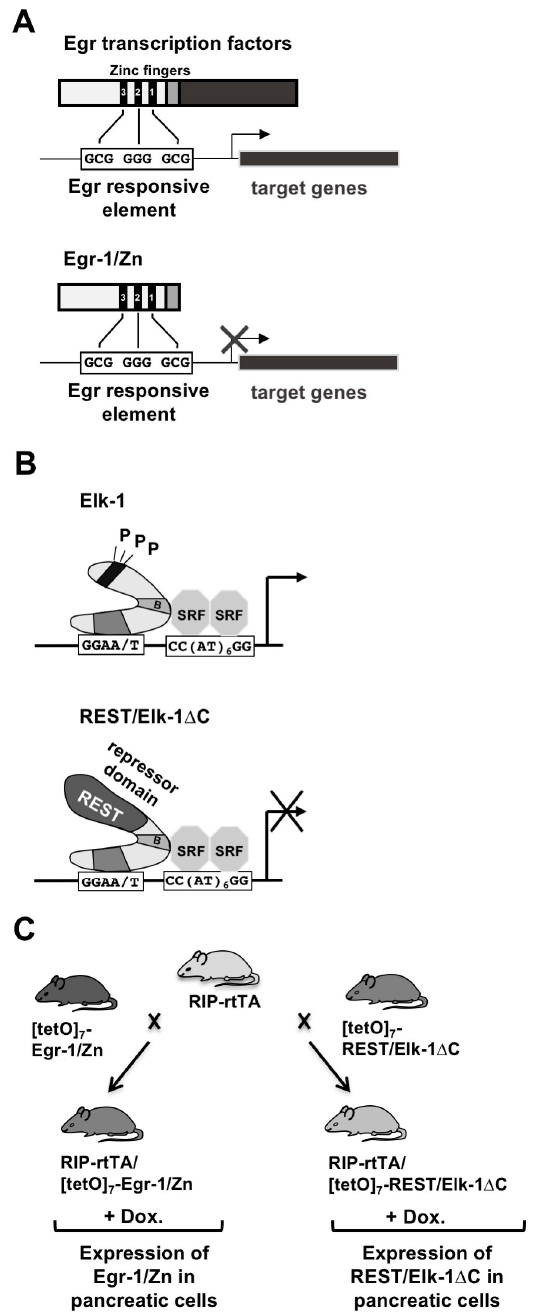
Figure 4. A transgenic strategy to overcome functional redundancy of protein families. ( A ) Egr-1/Zn functions as a dominant-negative for Egr proteins. Egr-1/Zn competes with Egr proteins for DNA binding. ( B ) REST/Elk-1 ∆ C functions as a dominant-negative for TCF proteins. REST/Elk-1 ∆ C competes with TCF proteins for DNA and SRF binding. In addition, the mutant induces chromatin compaction of SRE-regulated genes, due to the recruitment of histone deacetylases. ( C ) Crossing scheme to generate double transgenic mice expressing either Egr-1/Zn or REST/Elk-1 ∆ C in pancreatic β -cells. Reproduced with modifications from refs. [10,26] with permission from Oxford University Press and Elsevier.